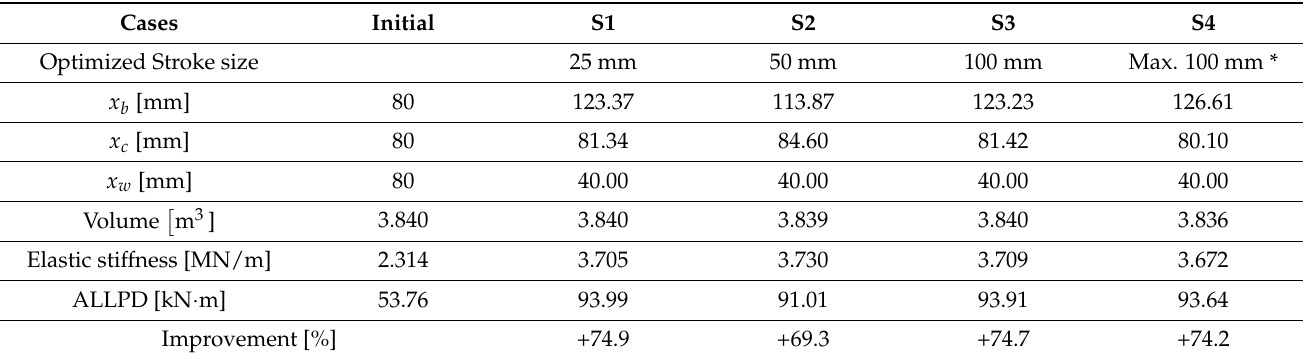
Figure 7. Plastic strain distribution (initial and S1) and stress distribution at the edge (S1).